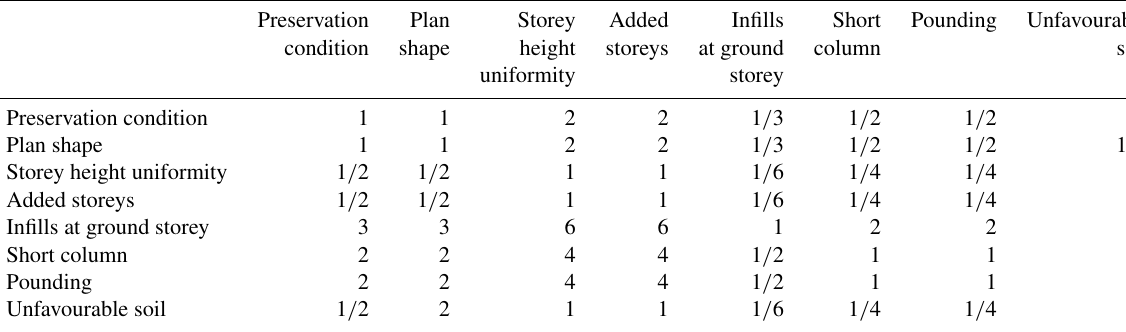
Table A4. Judgement matrix adopted for the calibration of the RC-building